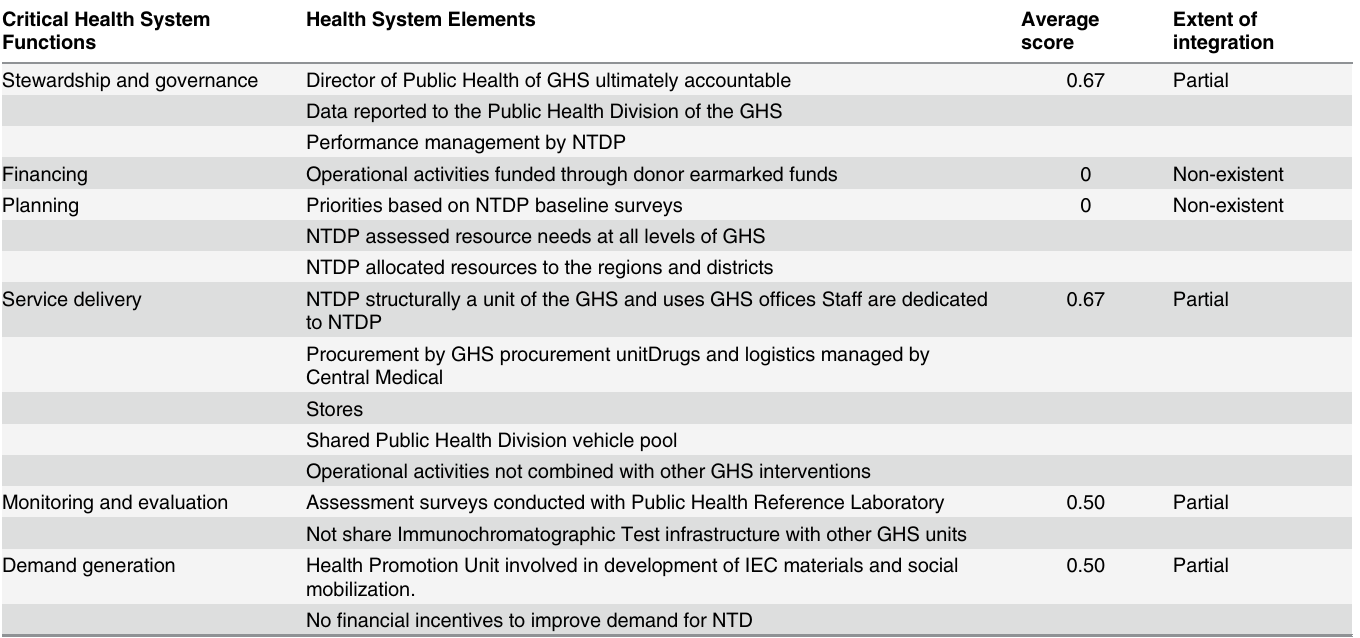
Table 2. Extent of integration of health system functions at national level of health